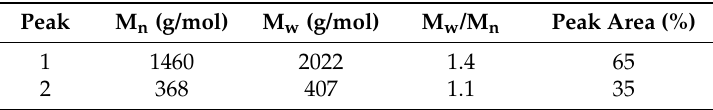
Table 2. Molecular weights and distribution of DGEBA-D400 adduct.